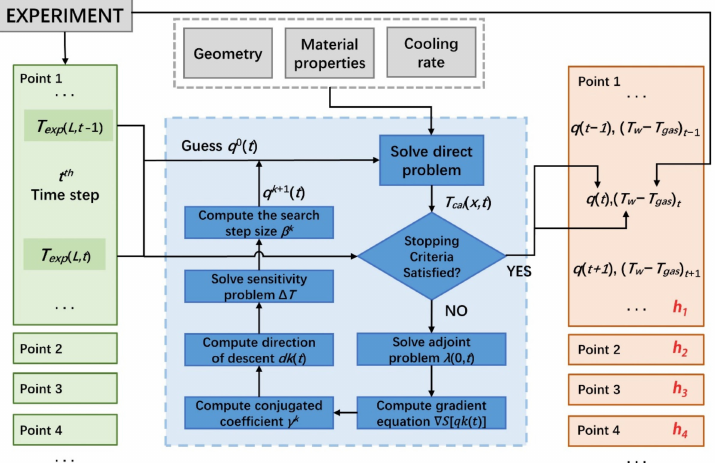
Figure 14. Solving IHCP